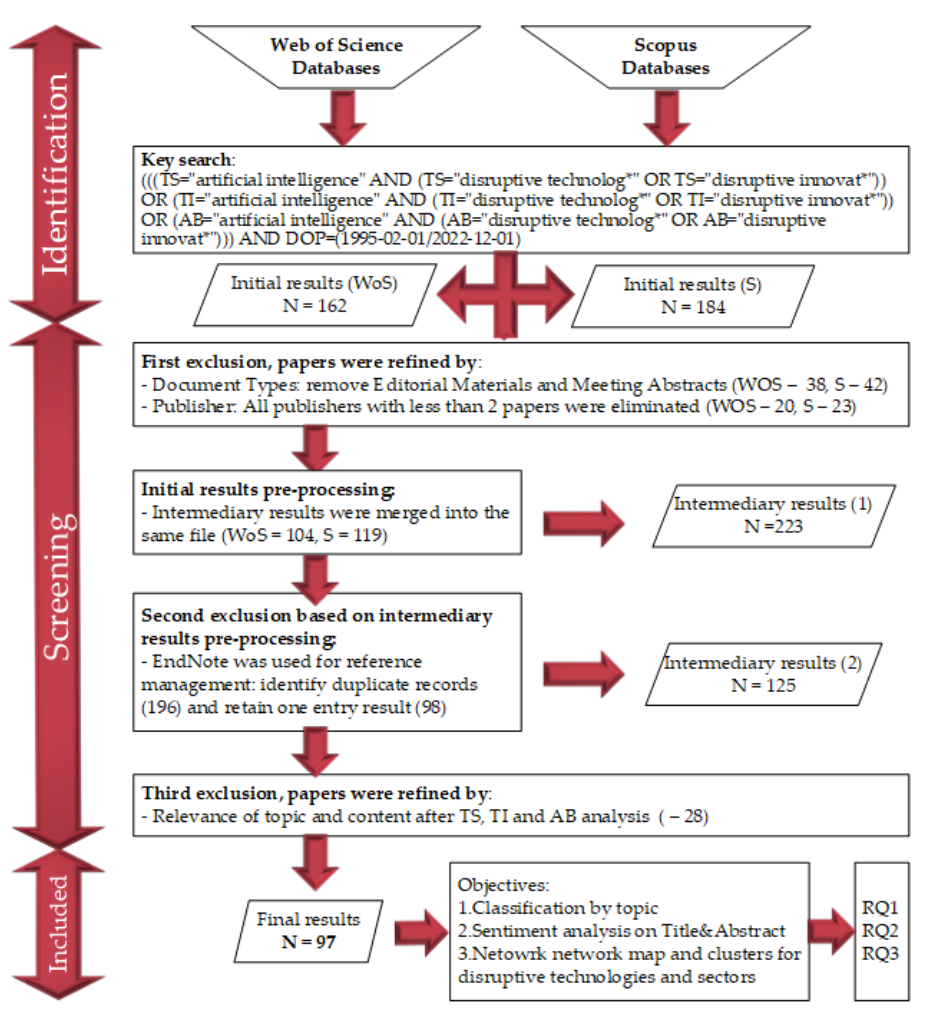
Figure 1. Research